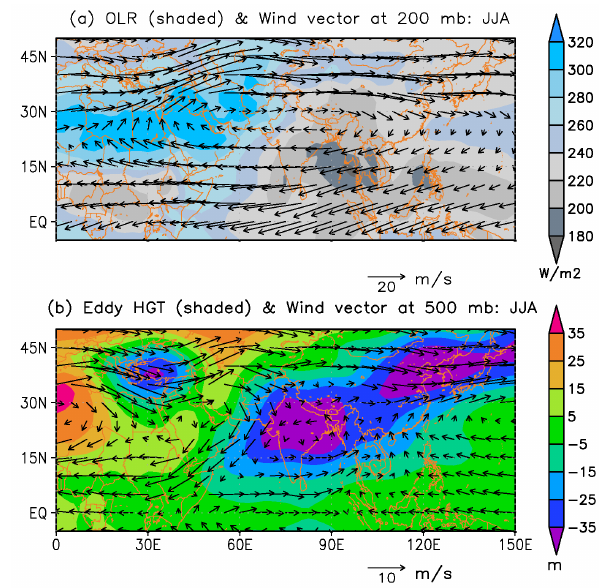
Fig. 7. Depiction of average meteorological parameters salient to the South Asian summer monsoon season (June-July-August); (a) NCEP outgoing longwave radiation (OLR) and wind vectors at 200mb height, (b) Eddy geopotential height (zonal mean sub- tracted) and wind vectors at 500mb height (data source: www.cdc. noaa.gov). The length of the wind vectors indicates wind speed as shown by the legends, separately for each panels. The response functions corresponding to 1PgCyr − 1 pulse emission from the South Asia region of TDI64 for February, May, August and Novem- ber at selected upper tropospheric locations are shown in Supple- ment Fig.